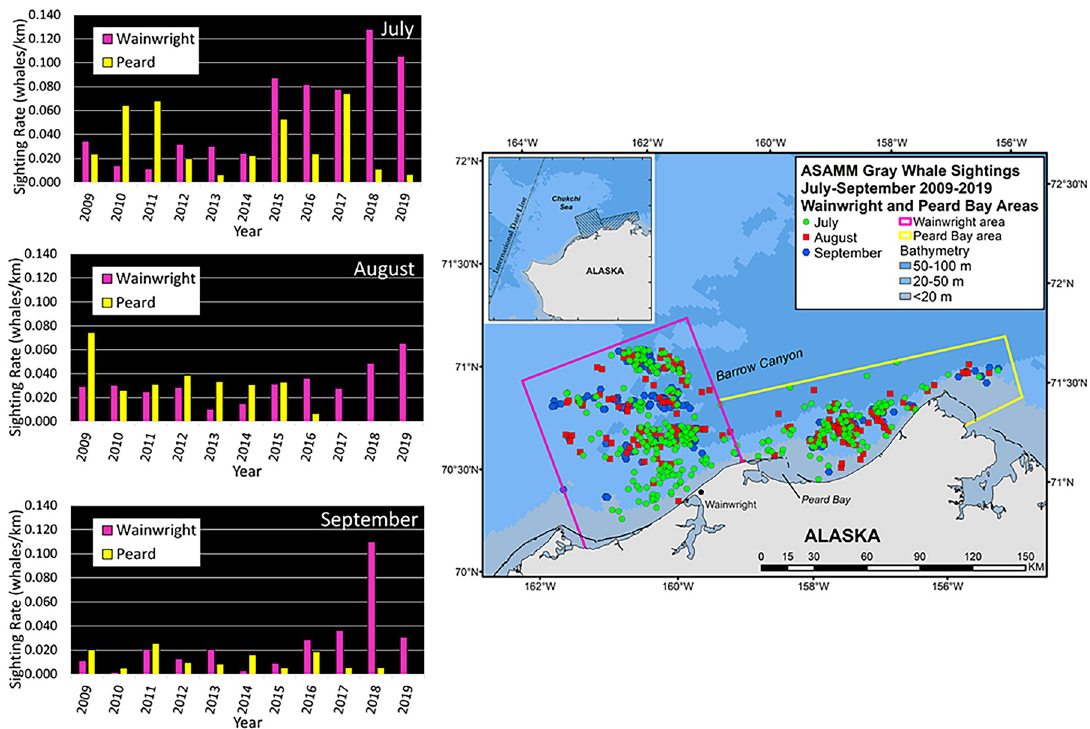
Fig 8. Interannual variability in gray whale monthly distribution and histogram of sighting rates (SR) for Wainwright and Peard Bay analytical areas in the northeastern Chukchi Sea, 2009–2019. Inset map shows the location of Wainwright and Peard Bay areas relative to the ASAMM study area. ASAMM data are publicly available at fisheries.noaa.gov/resource/data/1979-2019-aerial-surveys- arctic-marine-mammals-historical-database. Databases used for maps include versions 1979_2011_v3_36,